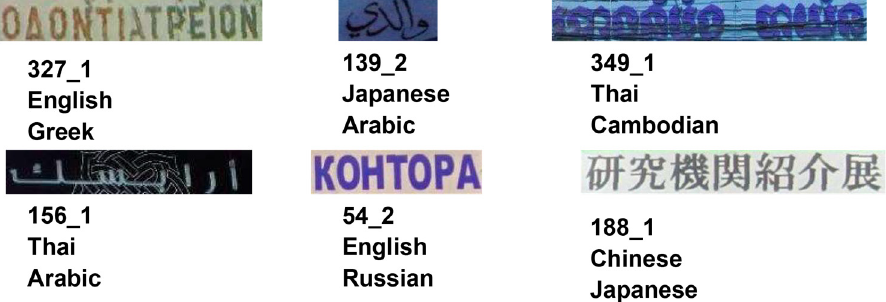
Figure 8. Samples of script identification errors in the SIW-13 dataset. The three lines of labels below each script are image id, identification result, and groundtruth.